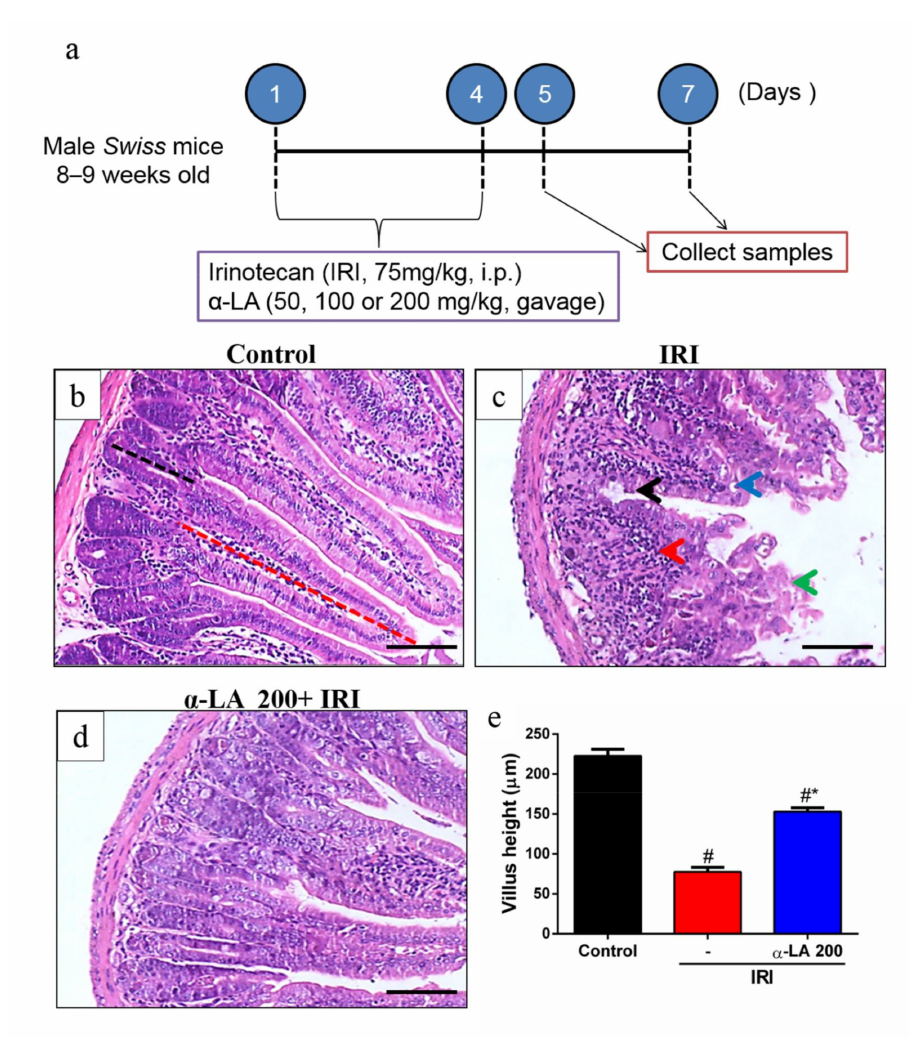
Figure 1. Alpha-lipoic acid ( α -LA) pretreatment attenuates irinotecan-induced duodenum damage in mice. ( a ) Experimental timeline of intestinal mucositis induced by irinotecan and α -LA pretreatment. ( b – d ) Hematoxylin and eosin staining of the duodenum from control mice ( b ), showing intact villi (red dotted line) and crypts (black dotted line). Mice with irinotecan (IRI)-induced intestinal mucositis (IRI group) ( c ), characterized by an intense inflammatory cell infiltrate (red arrow), cell vacuolization (blue arrow), shortened villi (green arrow) and loss of intestinal crypt architecture (black arrow). Mice with irinotecan (IRI)-induced intestinal mucositis receiving α -LA pretreatment ( d ). Scale bars = 100 µ m. ( e ) Bars represent ± SEM of the villus height (ten villi per slide, n = 6) in µ m. # represents p < 0.05 versus the control group, and * indicates p < 0.05 versus the IRI group. One-way ANOVA followed by Bonferroni’s